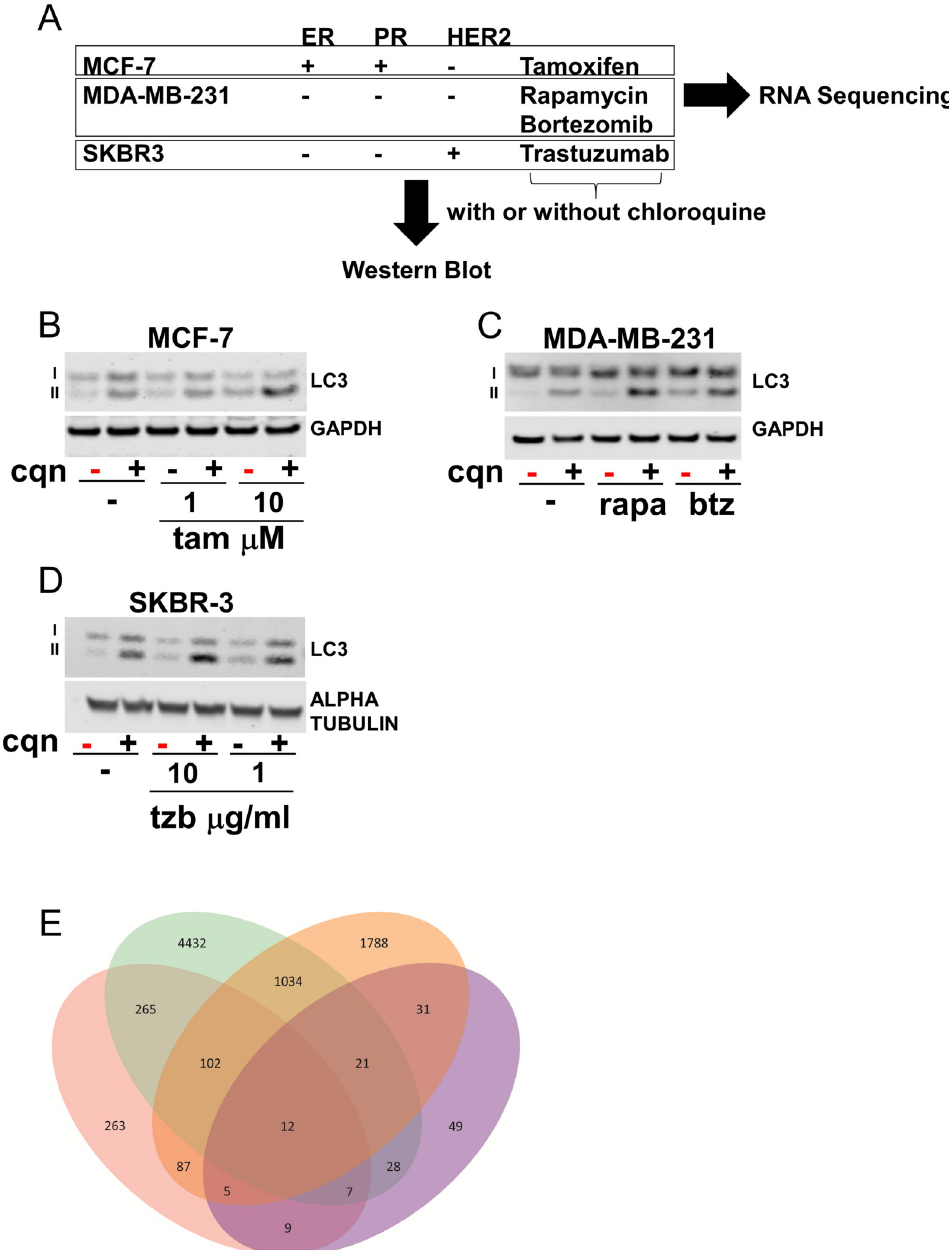
Fig 1. Drug induced autophagy flux and transcriptional profiling in breast cancer cell lines. A) Schematic with receptor status, cell lines and drugs used for western blot and sequencing analysis. B) MCF-7 cells treated with tamoxifen (tam) 1 and 10 μ M in presence and absence of chloroquine (cqn) 10 μ M for 16 hours. C) MDA-MB-231 cells treated with rapamycin (rapa) 200 nM and bortezomib (btz) 1 μ M in presence and absence of chloroquine 10 μ M for 8 hours. D) SKBR-3 cells treated with trastuzumab (tzb) 10 and 1 μ g/ml in presence and absence of chloroquine 10 μ M for 16 hours. Samples marked with red represent the conditions chosen for the RNA extraction for sequencing experiments. E) Venn diagram with common genes between the 4 groups of treatments. Each color represents the unique subset of genes from the differential expression analysis between no treatment and drug treatment (pink = rapamycin 200 nM, green = bortezomib 1 μ M, orange = tamoxifen 10 μ M, purple = trastuzumab 10 μ g/ml). Transcriptional expression is depicted as fold changes over the basal levels for all the com- mon mRNAs in MDA-MB-231, MCF-7 and SKBR-3 cells. All tested drugs upregulated levels